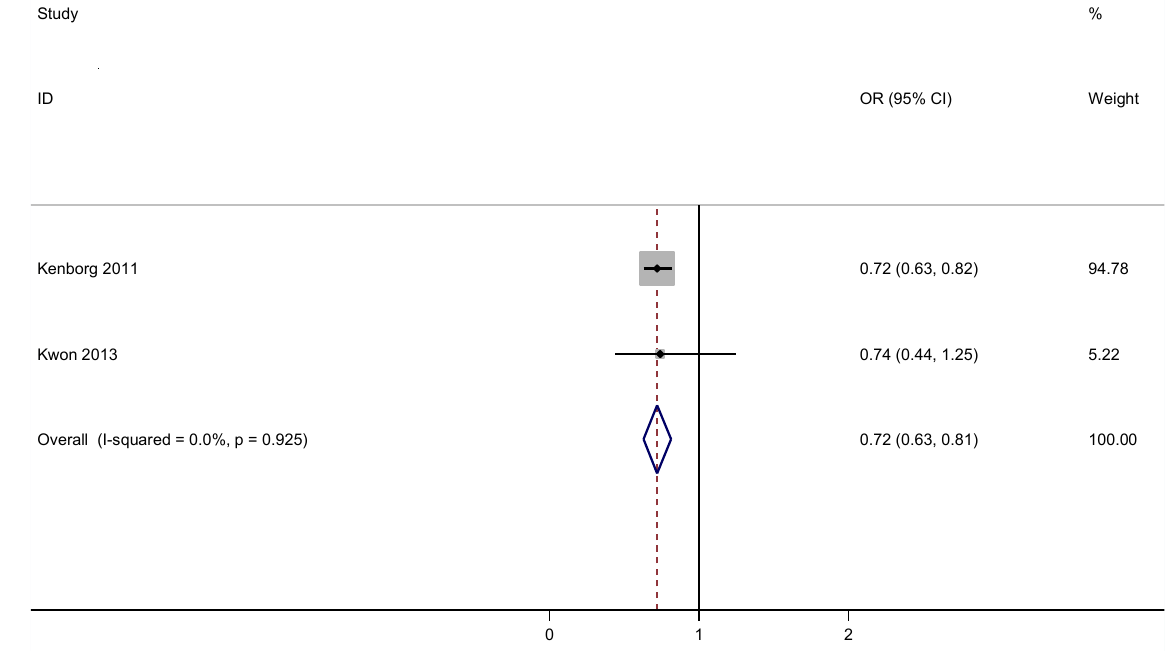
Figure 4. Forest plots of outdoor work and risk of